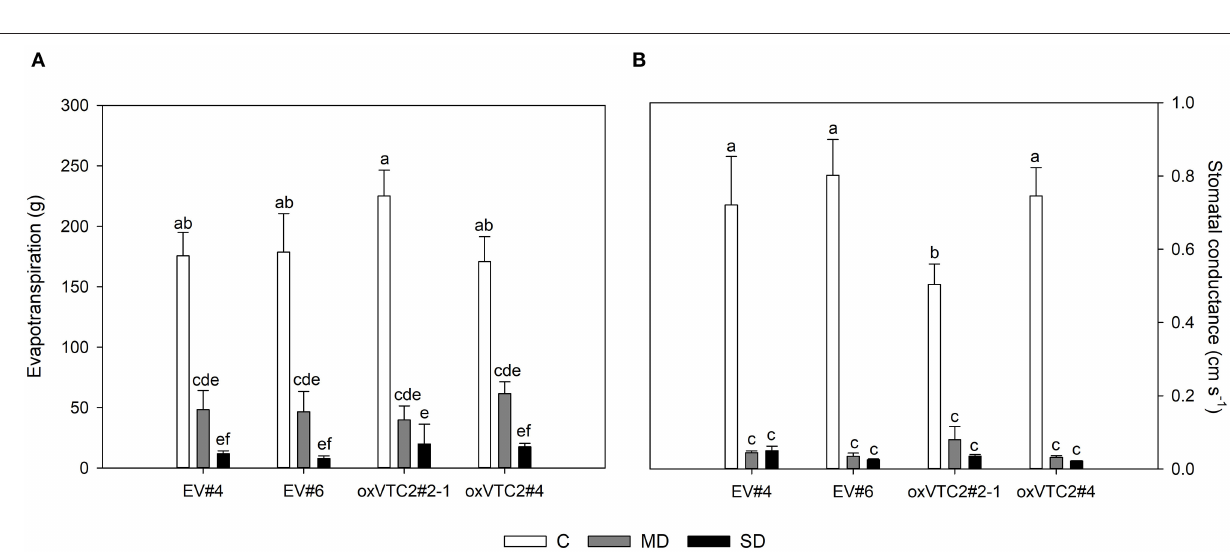
FIGURE 4 | Effects of progressive drought stress on evapotranspiration (A) and stomatal conductance (B) in M. truncatula empty vector (EV) and oxVTC2 plants under well-watered control (C), mild drought (MD), and severe drought (SD) conditions. Values represent the average ± SE ( n = 5 biological replicates). Mean values represented by the same letter do not differ statistically ( p ≤ 0.05 ANOVA